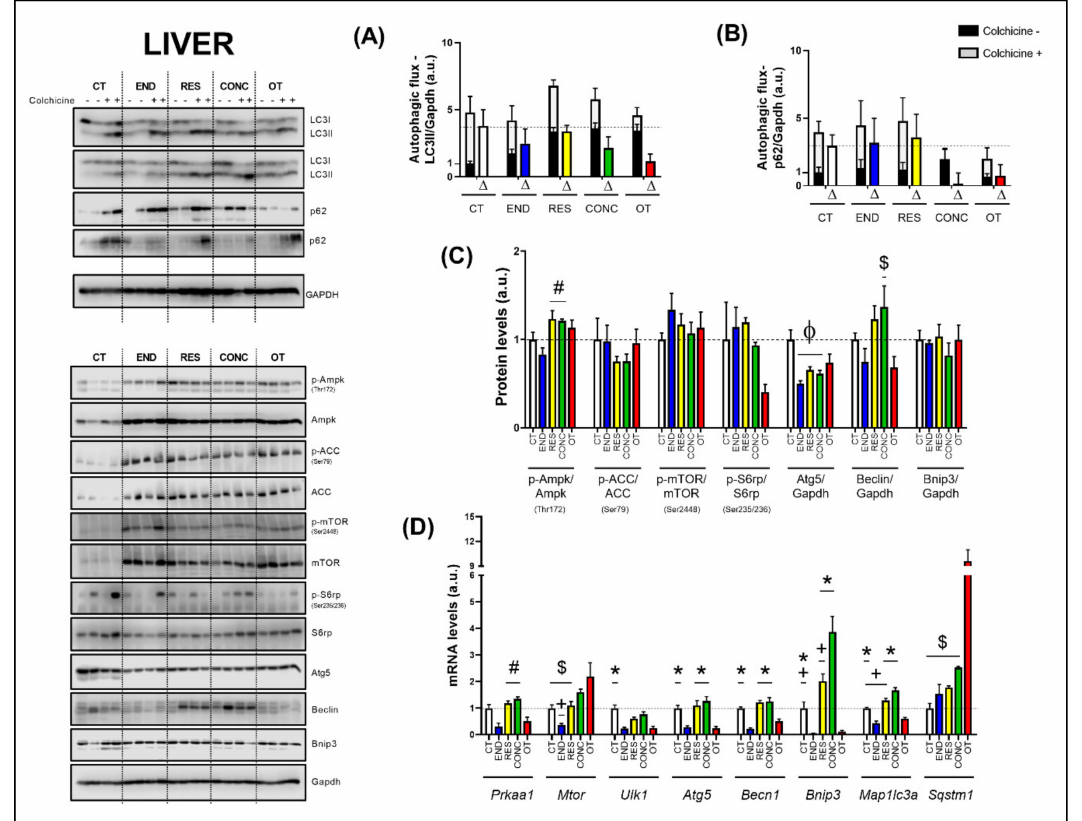
Figure 2. Autophagic flux for LC3II / Gapdh ( A ) and p62 / Gapdh ( B ) in the liver. Protein levels of p-Ampk / Ampk, p-ACC / ACC, p-mTOR / mTOR, p-S6rp / S6rp, Atg5 / Gapdh, Beclin / Gapdh, Bnip3 /